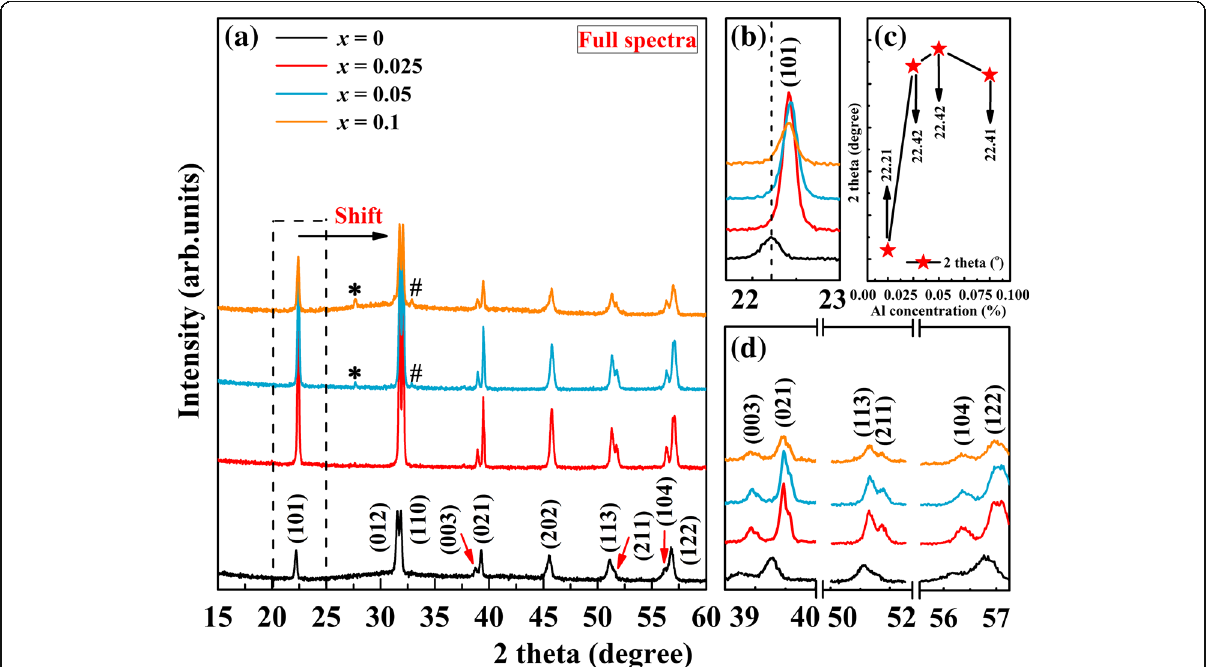
Fig. 1 a XRD patterns of BFA x O (0 ≤ x ≤ 0.1). b Enlarged view of the XRD patterns in the range of 21 – 24°. c The (101) peak position as a